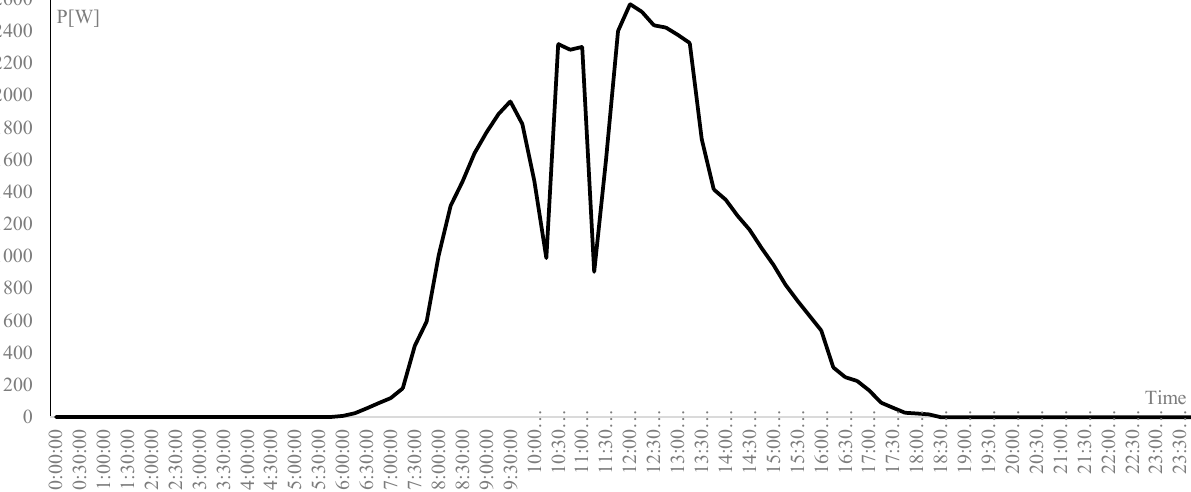
Figure 12. Load power profile.